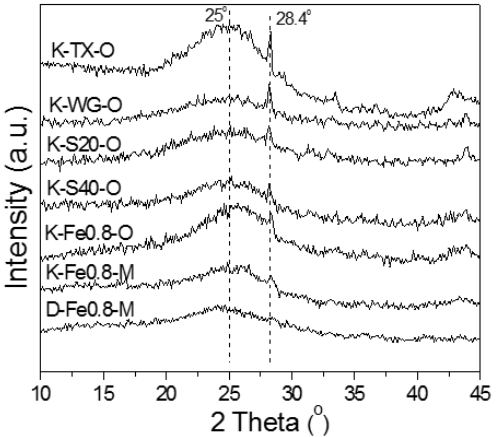
Figure 3. XRD patterns of the prepared catalysts samples: K-TX-O, K-WG-O, K-S20-O, K-S40-O, K-Fe0.8-O; K-Fe0.8-M and D-Fe0.8-M.